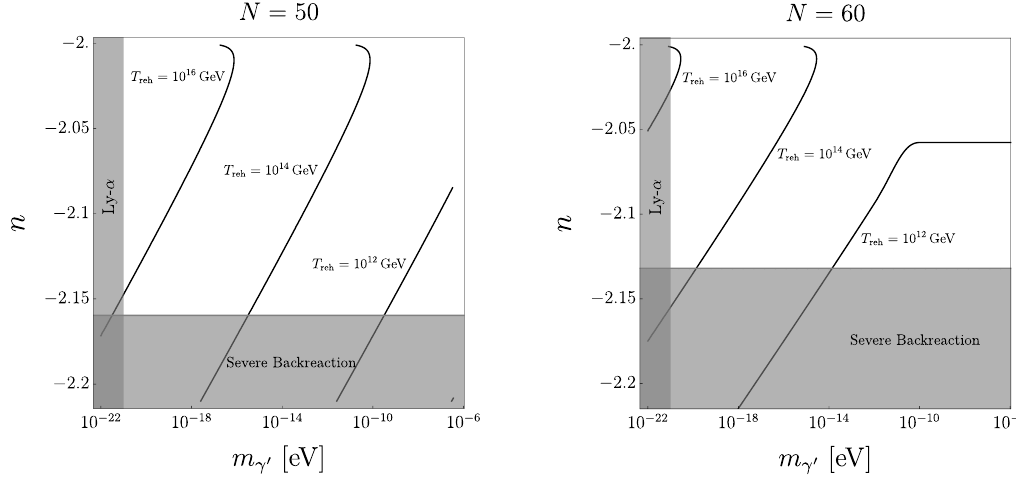
Figure 1 . Plots of parameters that give the correct relic abundance of the dark photon dark matter as a function of m γ 0 and n . The left and right panels correspond to the cases of N = 50 and N = 60 , respectively. We here take g ∗ ( t 0 ) = 2 and relate ρ ( t end ) and T reh by (4.16). The three solid curves denote the cases where the reheating temperature is T reh = 10 16 , 10 14 , 10 12 GeV . The lower gray region is excluded by the constraint to avoid strong backreaction of the produced dark photon onto the background inflationary dynamics. The dark photon mass of m γ 0 . 10 − 21 eV is excluded by the constraints from Lyman- α forest [33] and black-hole superradiance